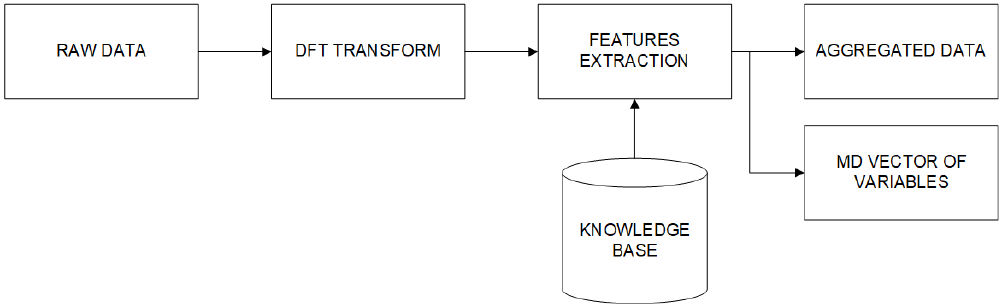
Figure 2. Features extraction procedure for 1D and MD